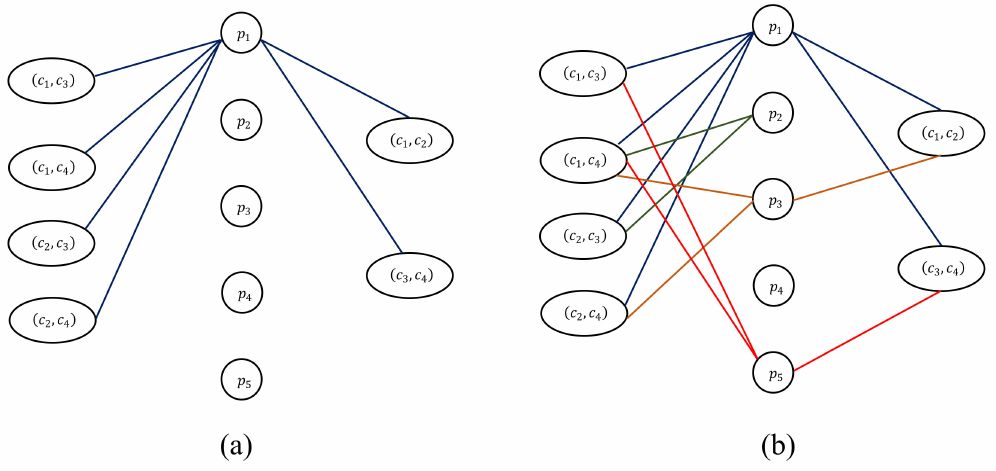
Figure 2. Optimum solution of the α , β - k -FSP ( a ) for α = β = 1 and ( b ) α = β =